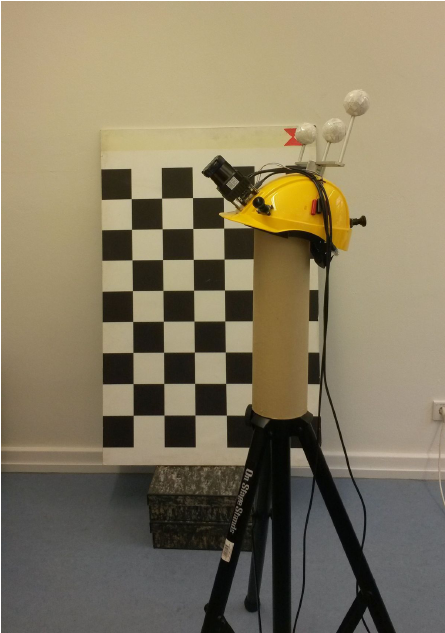
Figure 4. Extrinsic laserscanner to fisheye camera